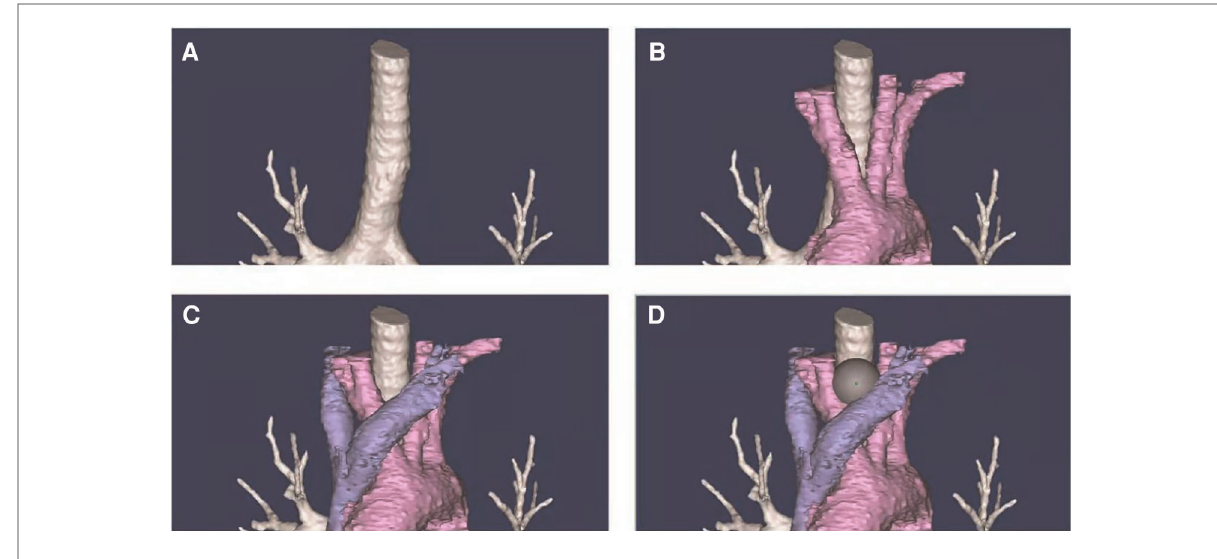
FIGURE 6 Regional anatomy in the upper mediastinum. Three-dimensional reconstruction shows the anatomy in the upper mediastinum. Innominate veins ( C ) and major arteries ( B ) could be observed. The classic retrosternal goiter locates in the niche of great vessels and the trachea ( D